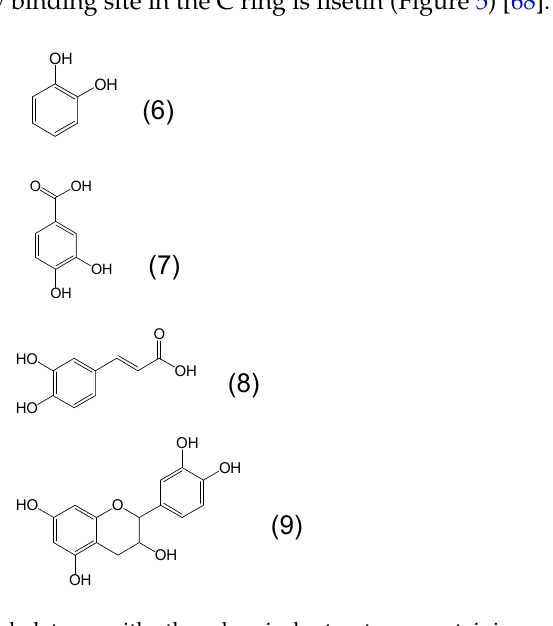
Figure 4. Examples of phytochelators with the chemical structure containing trihydroxybenzene as the metal binding site moiety. Gallic acid or 3,4,5-trihydroxybenzoic acid ( 10 ), epigallocatechin or (2 R ,3 R )-2-(3,4,5-trihydroxyphenyl)-3,4-dihydro-2 H -chromene-3,5,7-triol ( 11 ) and tannic acid or 2,3-dihydroxy-5-({[(2 R ,3 R ,4 S ,5 R ,6 R )-3,4,5,6-tetrakis({3,4-dihydroxy-5-[(3,4,5-trihydroxyphenyl)carbo nyloxy]phenyl}carbonyloxy)oxan-2-yl] methoxy}carbonyl)phenyl 3,4,5-trihydroxybenzoate ( 12 ).